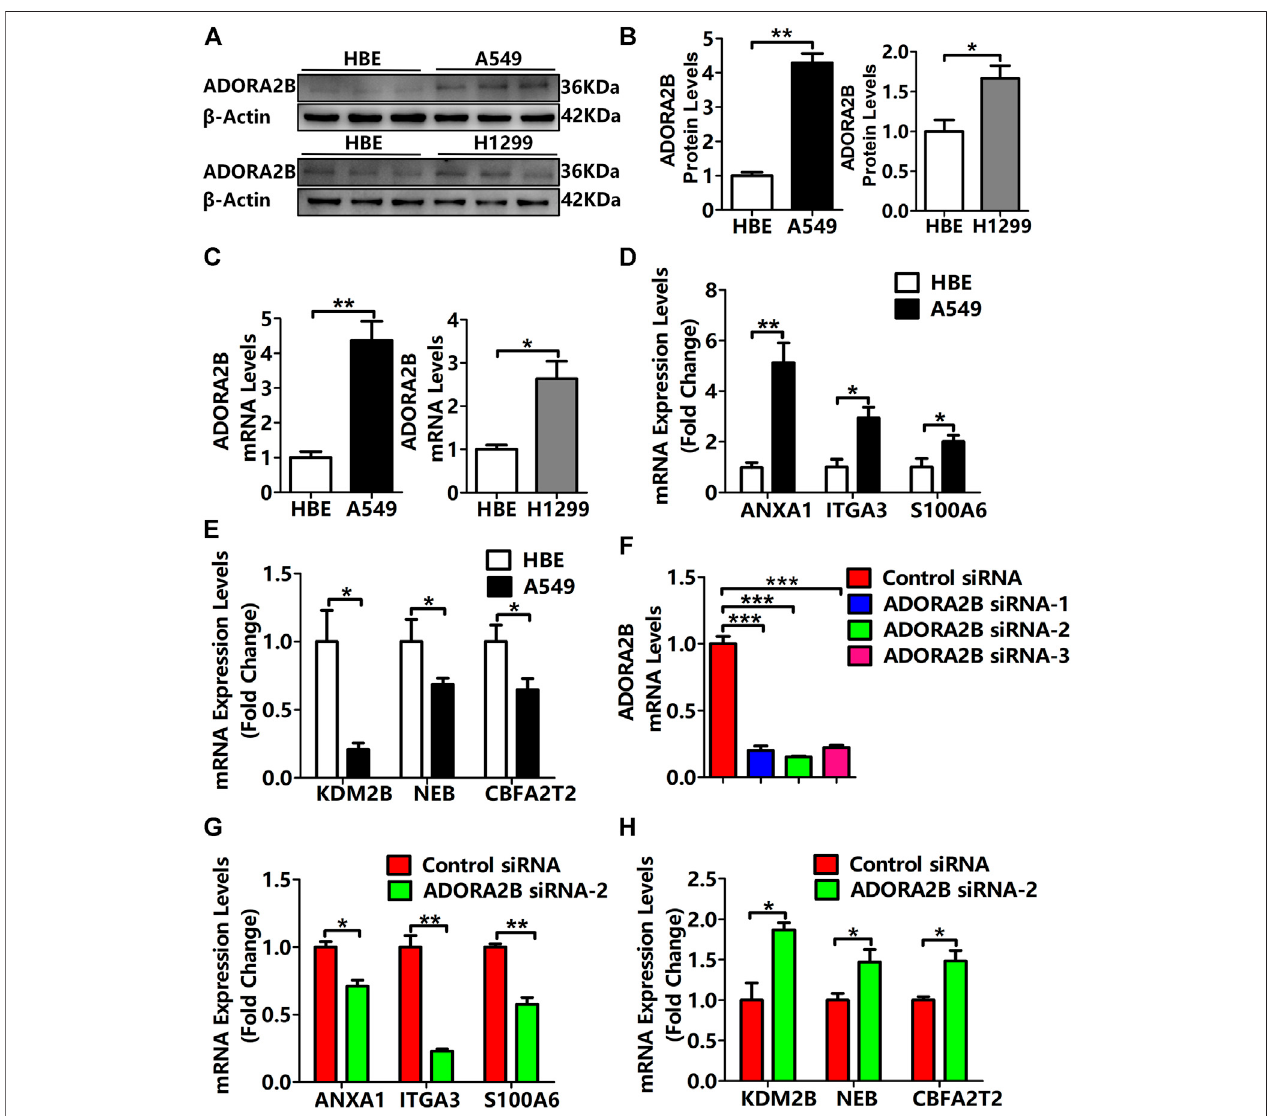
FIGURE 8 | Expression levels of ADORA2B and correlated genes in human LUAD cells. (A) Relative protein expression of ADORA2B was determined by western blotting. (B) Protein quantitative statistics. (C) Relative mRNA expression of ADORA2B was determined by qRT-PCR. mRNA expression levels of genes (D) positively and (E) negativelycorrelatedwith ADORA2B . (F) mRNAexpressionlevelsof ADORA2B aftersiRNAtransfection. mRNAexpressionlevelsofgenes (G) positivelyand (H) negatively correlated with ADORA2B after siRNA transfection. * p < 0.05, ** p < 0.01, and *** p < 0.001 are statistically signi fi cant.